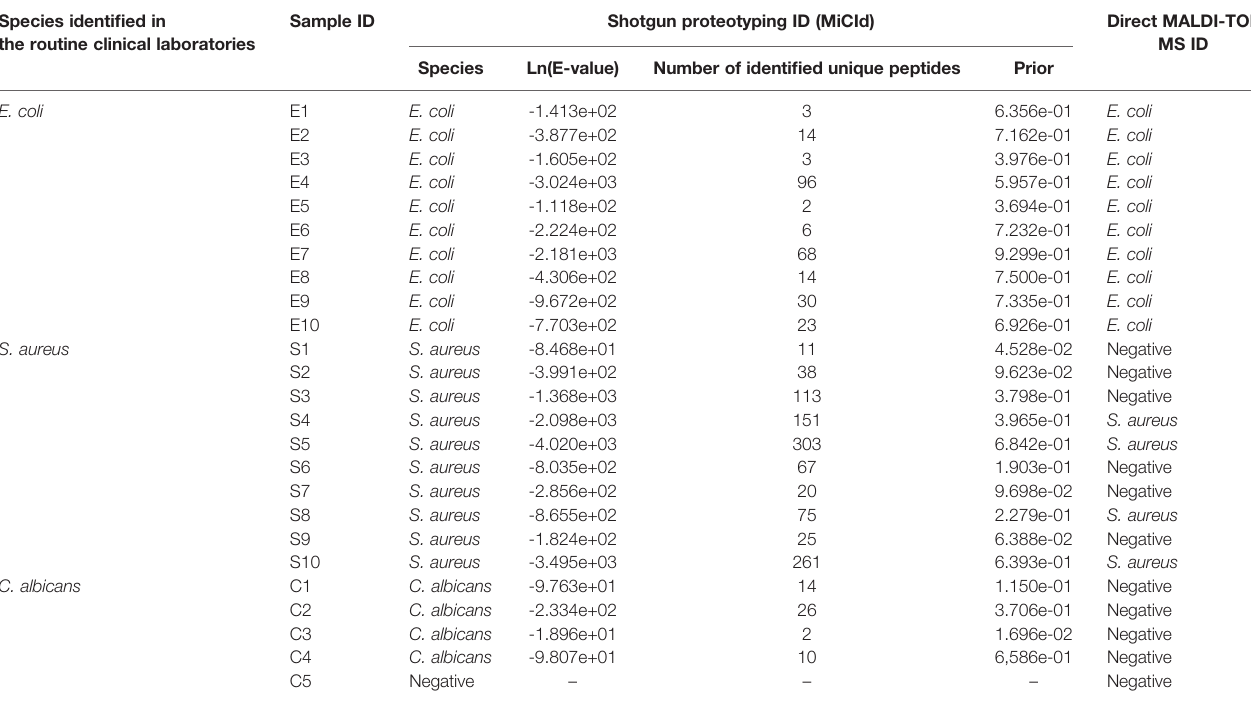
TABLE 3 | Comparison of identi fi cation accuracies of MALDI-TOF MS and shotgun proteotyping. Species identi fi ed in the routine clinical laboratories